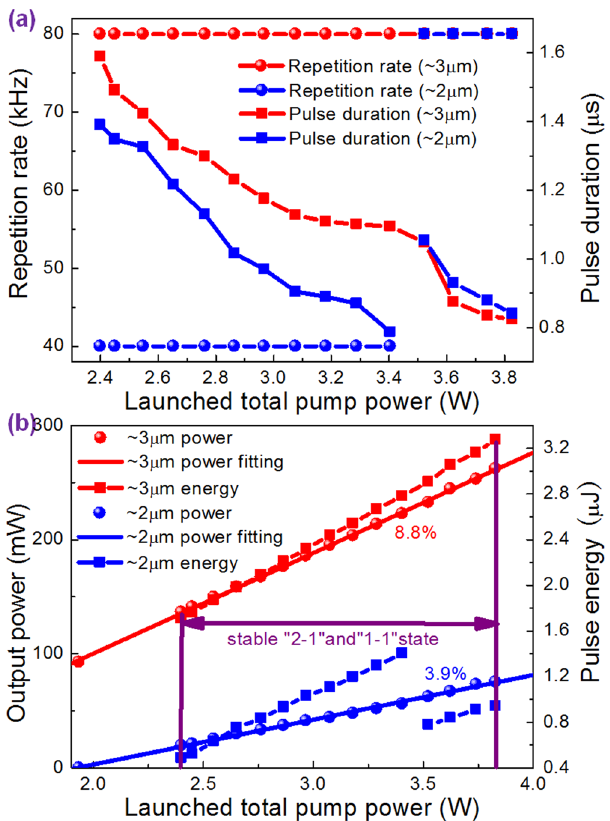
Figure 3. The output performances of dual-waveband gain-switched fiber laser. ( a ) Repetition rate and pulse duration and ( b ) output power and pulse energy as a function of the